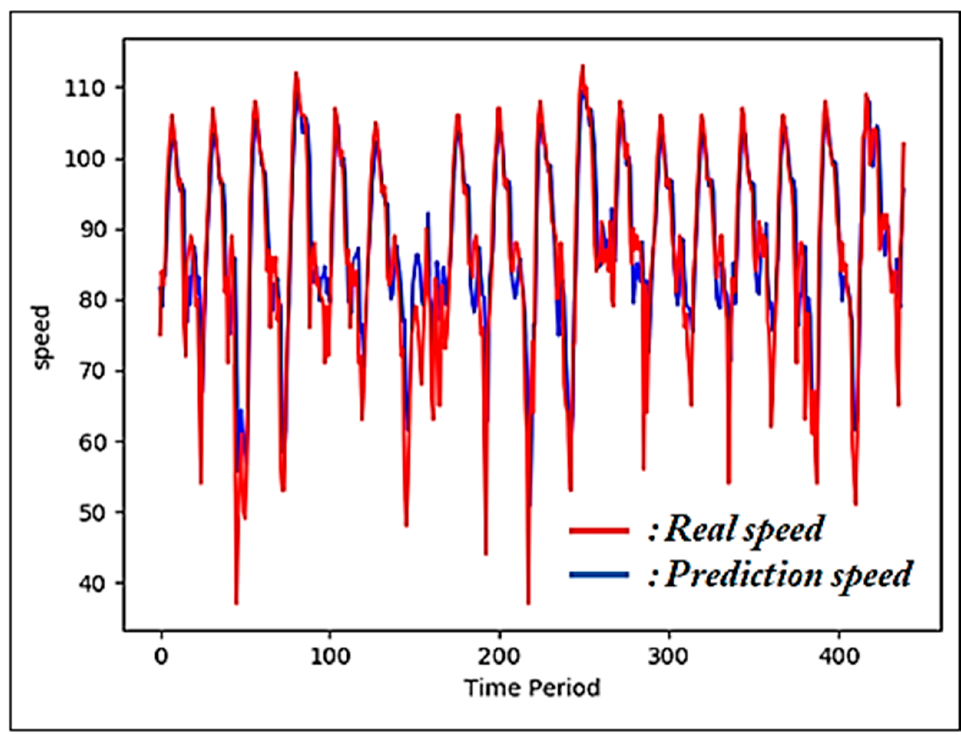
Figure 3. Graph comparing the actual speeds and predicted speeds considering the effects of the speeds of connected roads.